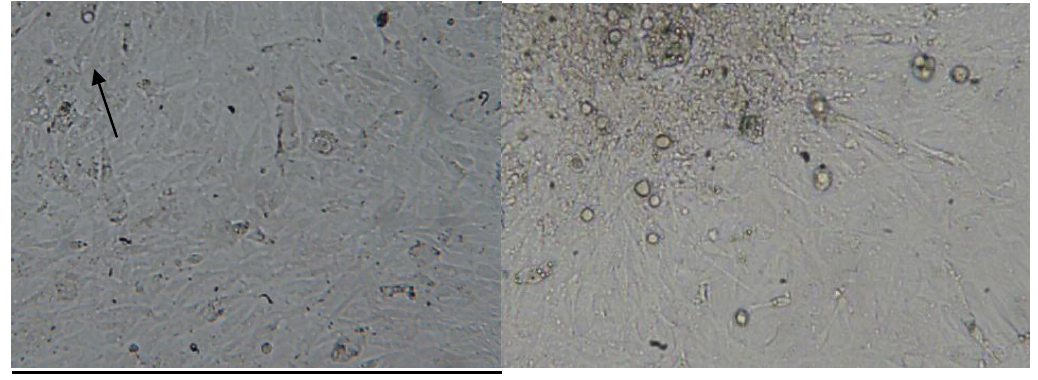
Figure 5: Infected Chicken embryo fibroblast cell cultures 100X after 5 days of virus inoculation (3 passages), focal rounding of cells with formation of giant cells Figure 6: Normal Chicken embryo fibroblast cell cultures 100X